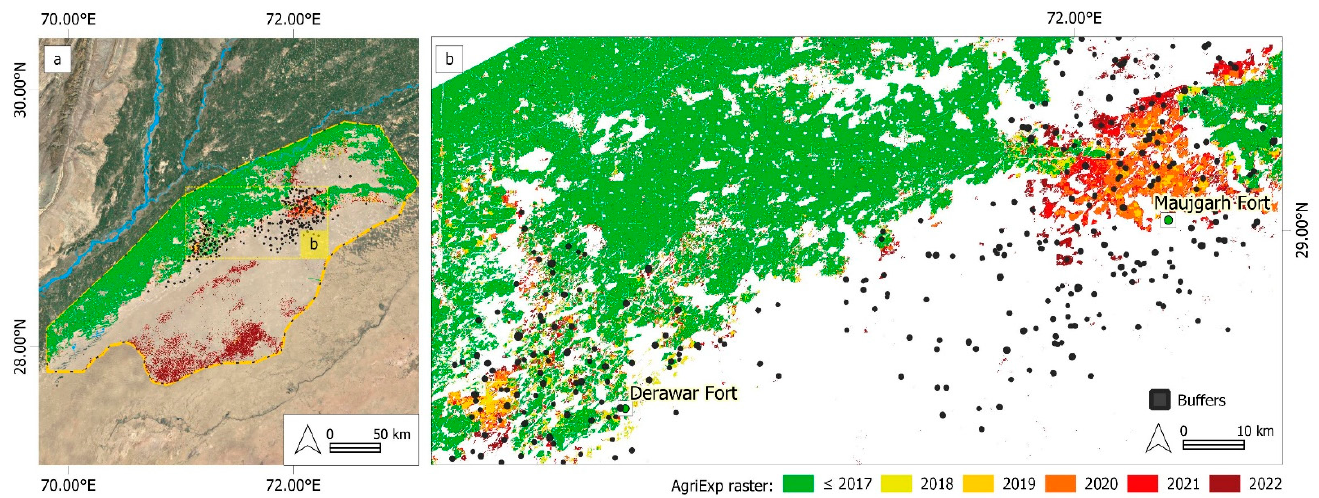
Figure 5. ( a ) AgriExp’s raster output for the AOI; ( b ) inset showing the main regions of recent agricultural development in the Cholistan Desert: the northern area of Maujgarh Fort and west of Derawar Fort.